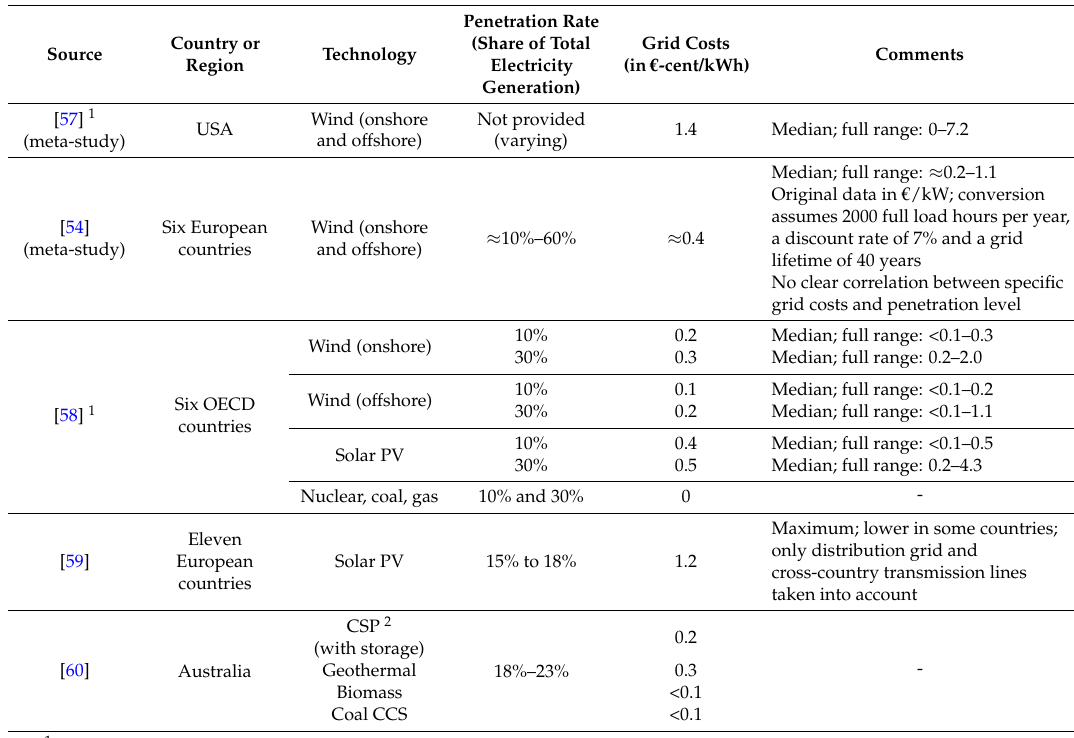
Table 2. Additional specific grid costs of different electricity generation technologies at varying penetration rates according to several